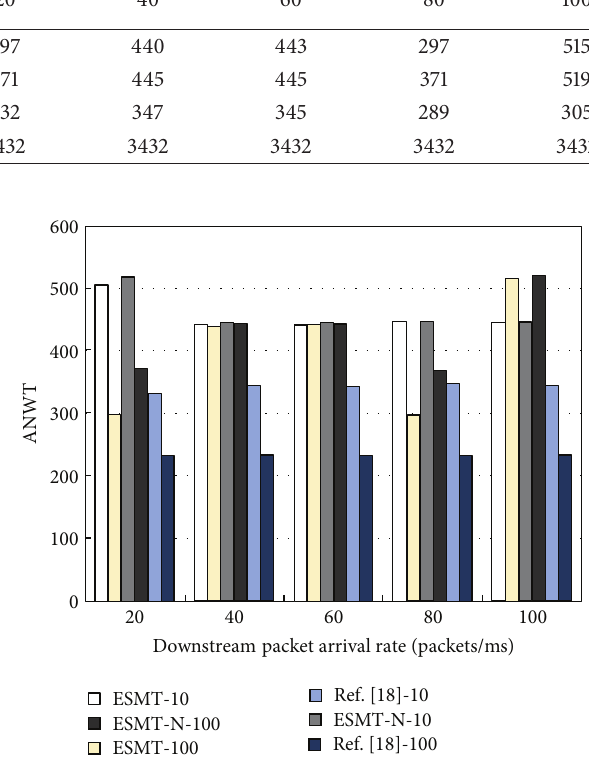
Figure 10: The average packet delay of the four algorithms given an upstream packet arrival rate of 10packets/ms.